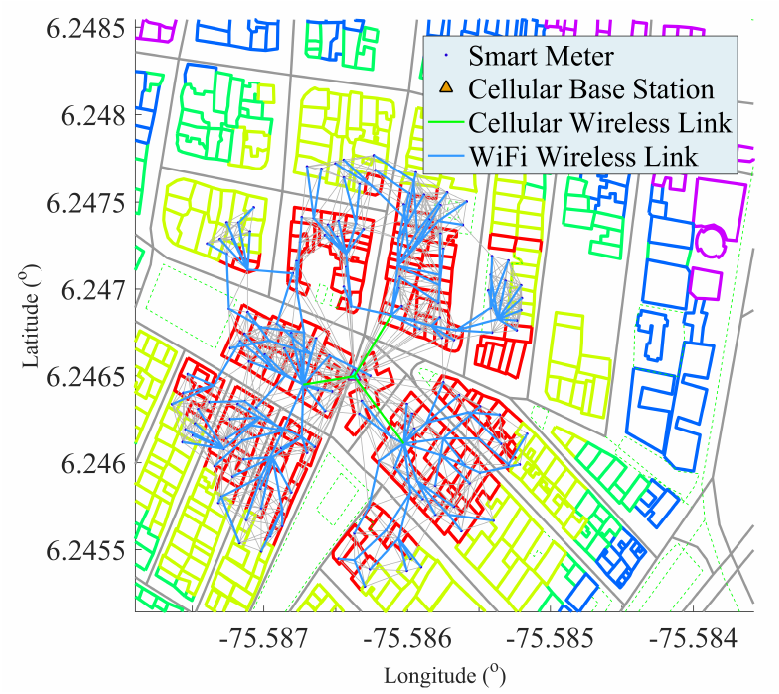
Figure 4. Initial topology of the cellular radio network with a 100 m coverage and WiFi radio with a 40 m coverage.